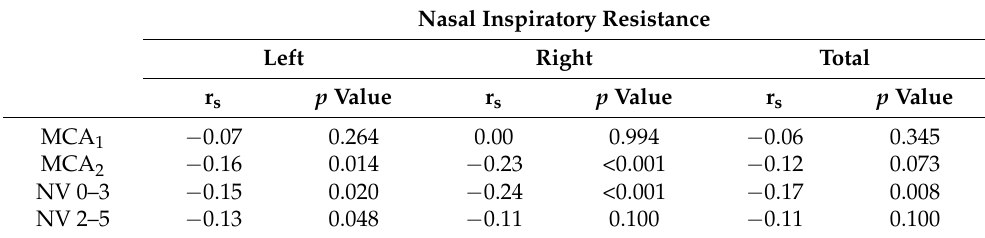
Table 7. Correlation of active anterior rhinomanometry and acoustic rhinometry. Nasal Inspiratory Resistance Left Right Total r s p